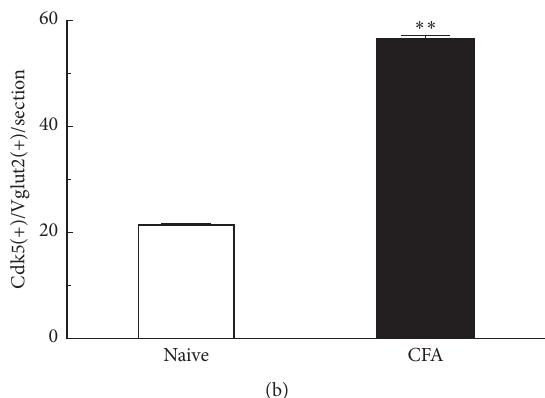
Figure 2: Coexpression of Cdk5 and VGLUT2 was increased in the spinal cord neuronal cells. Double-immunofluorescence staining for Cdk5 (red) and VGLUT2 (green). Compared with the control group by intraplantar injection of saline (A–F), the coexpression of Cdk5 and VGLUT2 was significantly increased in DRG neurons on day 1 following CFA injection (G–L). Data shown represent mean ± SEM; ∗∗ P < 0 . 01; n � 6/group.